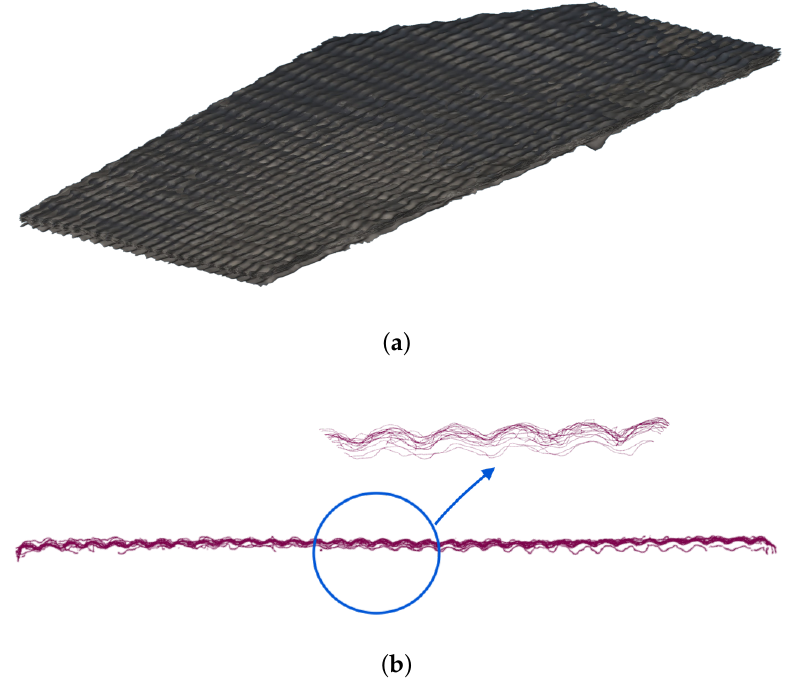
Figure 3. Results of alignment and segmentation of one of the roof features of the acquired building. ( a ) View of the aligned mesh for one of the recognized roof features; ( b ) 2D contours obtained from the cross section of the roof feature recognized in ( a